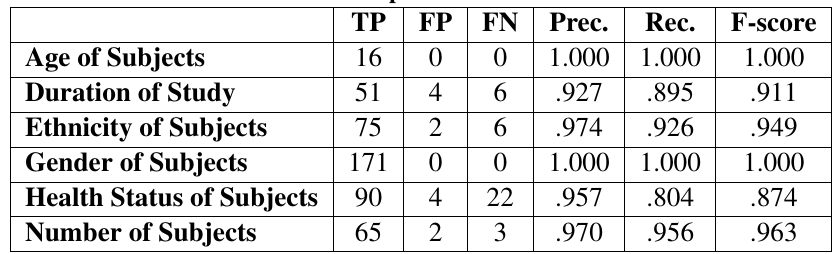
Table 1: Test set partial match